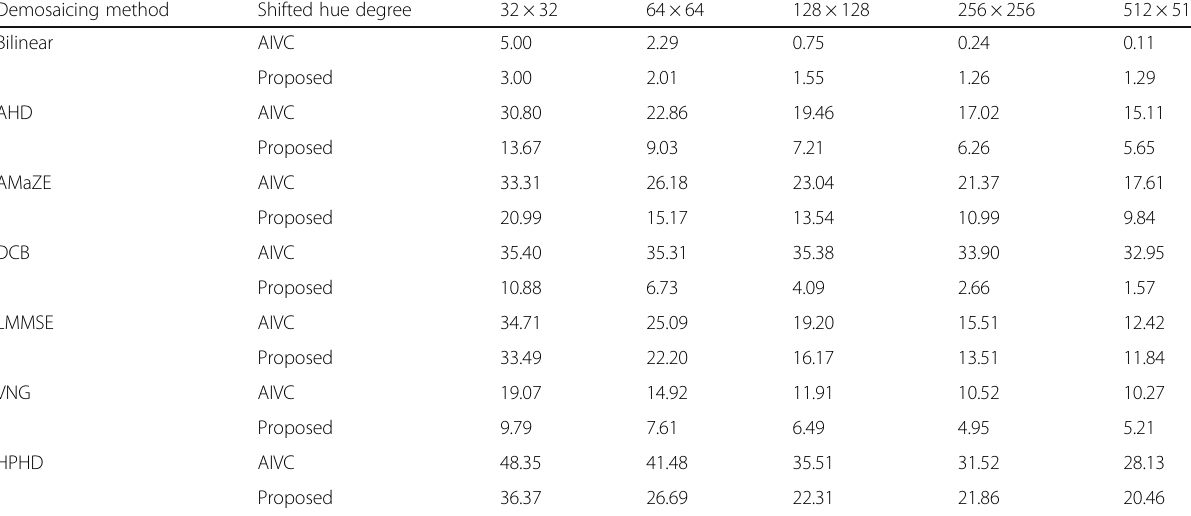
Table 6 Mean error value comparisons between our method and the AIVC algorithm for various block sizes Demosaicing